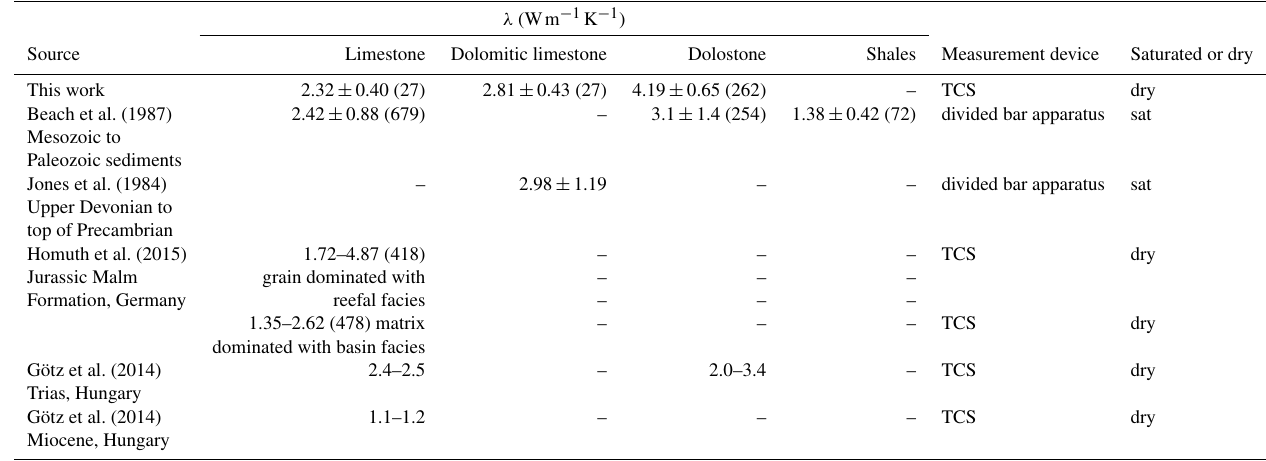
Table 4. Compilation of average thermal conductivity